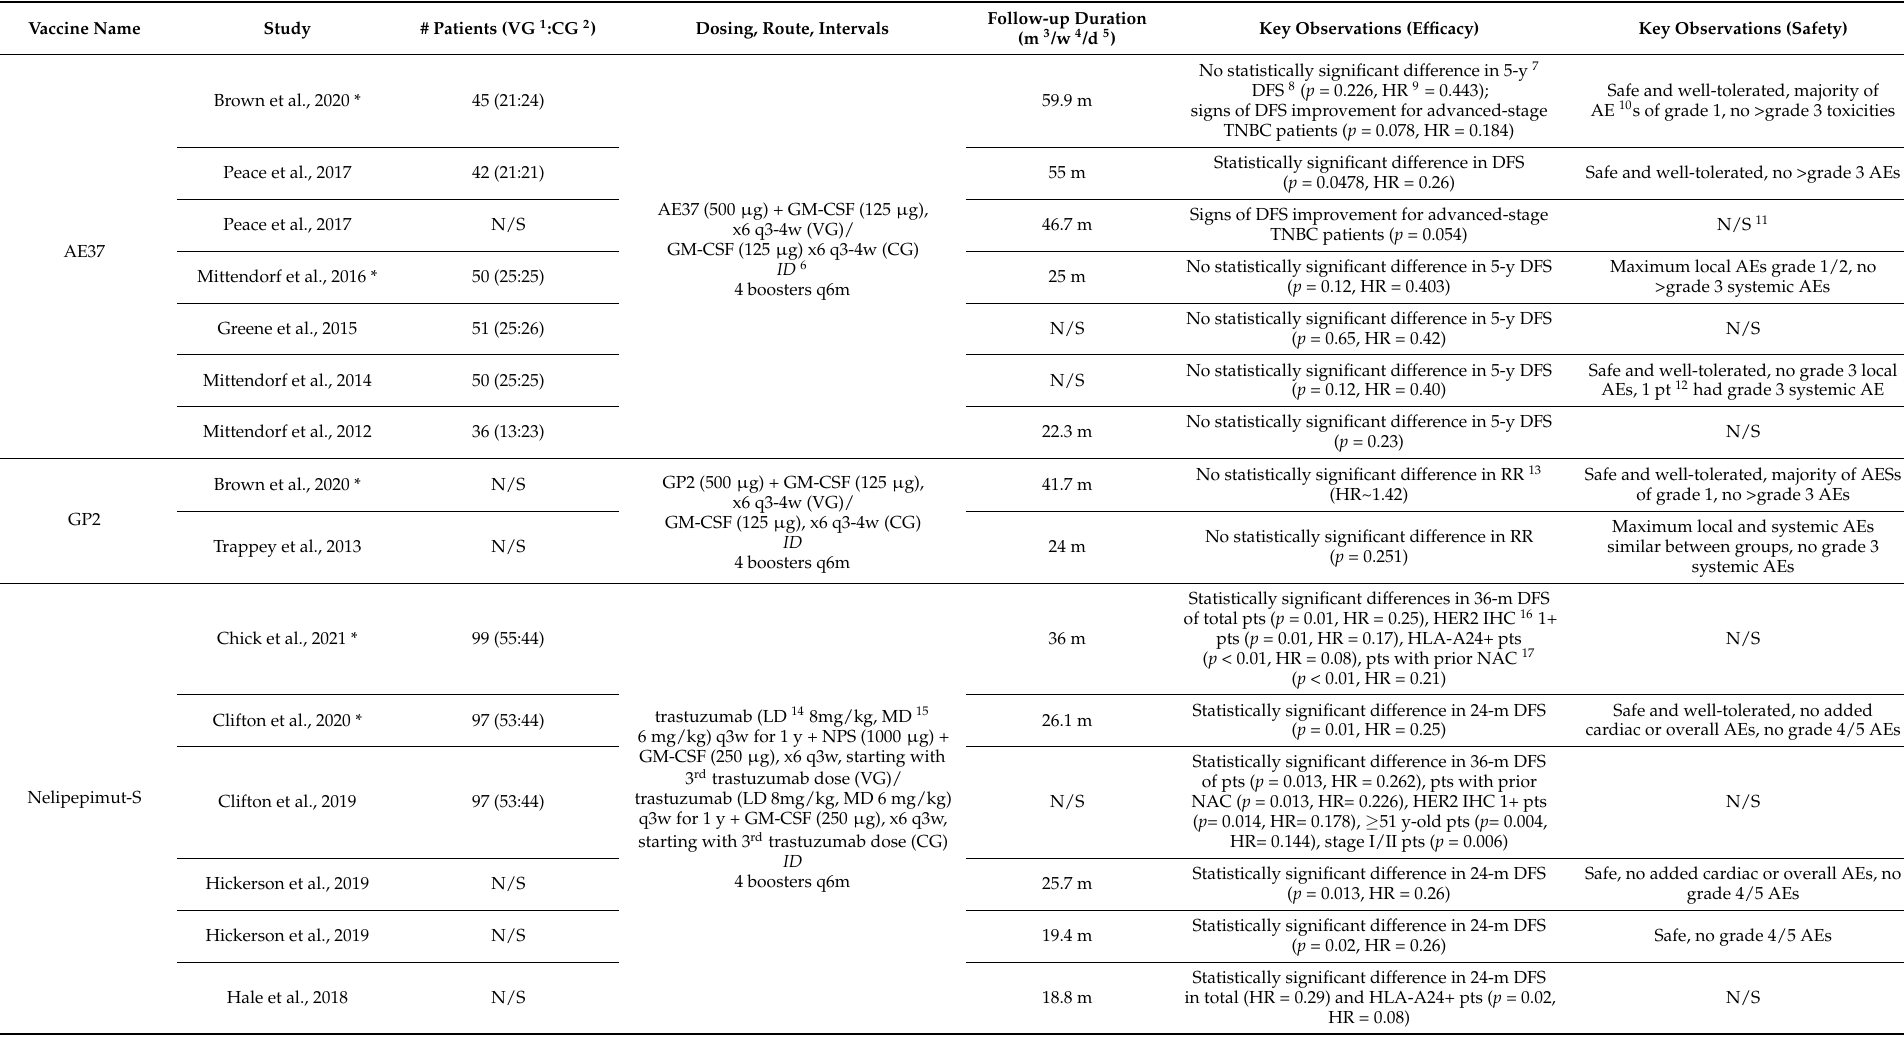
Table 2. Summary of study details of included studies. Full-text articles are marked with asterisks. All data, except safety, are presented for TNBC cohort of each